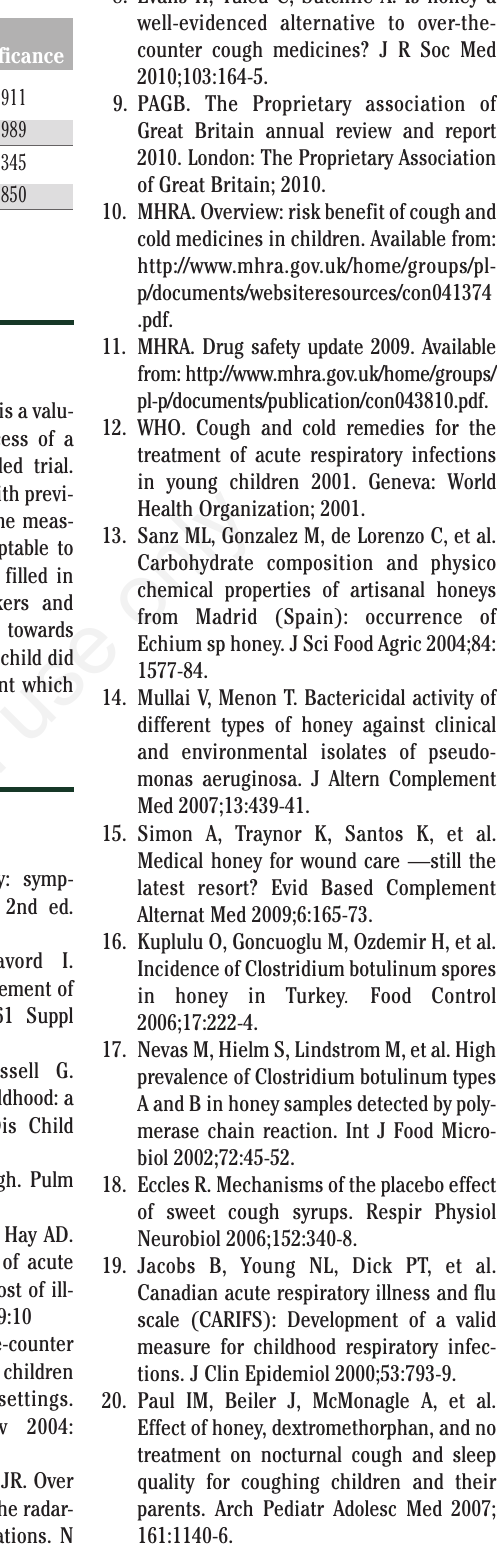
Table 1. Results of Pearson correlation coefficient and its significance. Cough score results analyzed for differences depending on age or gender of child and